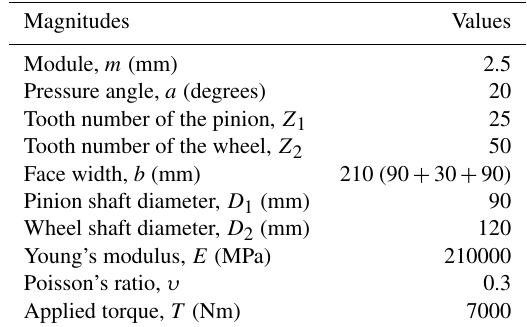
Figure 8. Model cutting schematic. (a) Single tooth cutting model. (b) Integral cutting model.